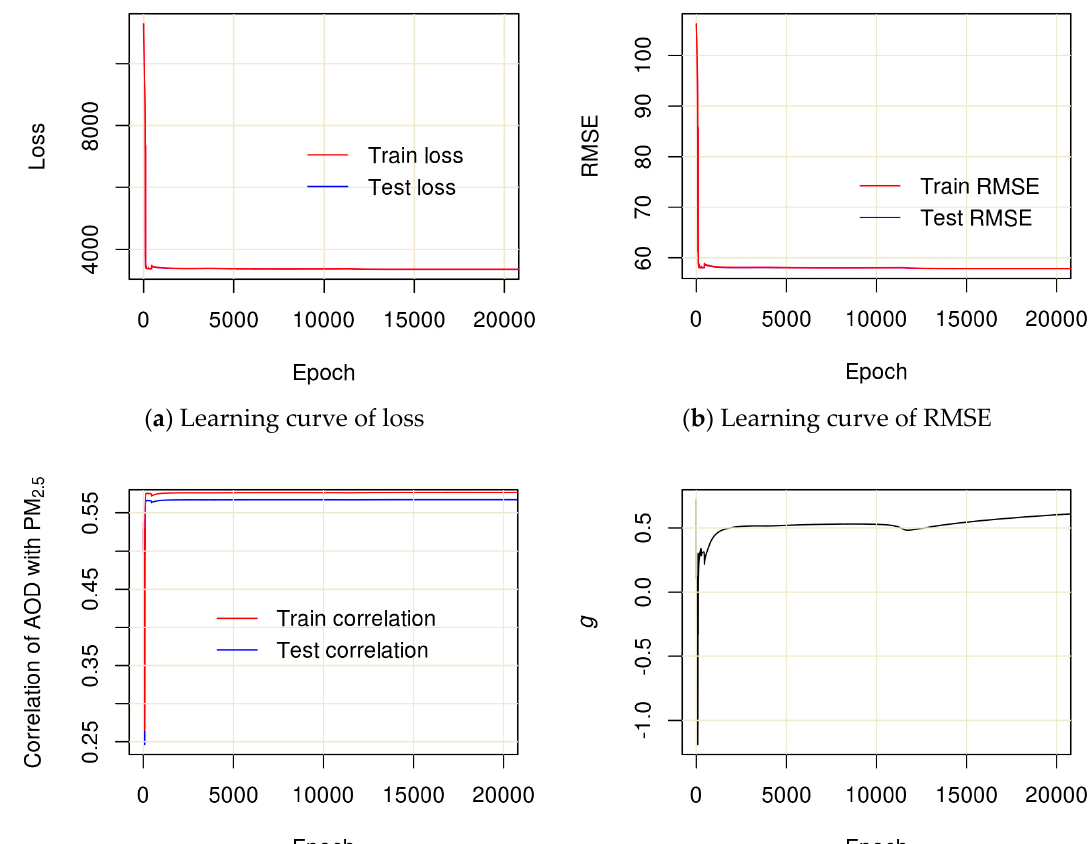
Figure 4. Optimal solution using the empirical method by varying g .